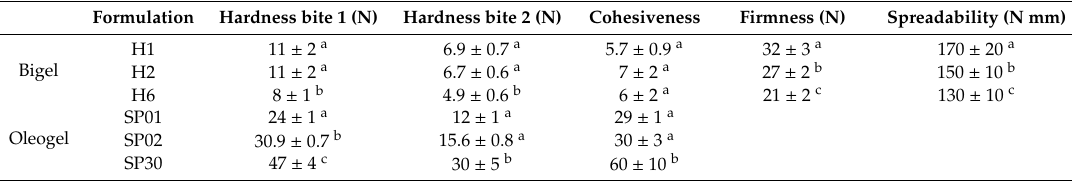
Table 4. Mechanical analysis results obtained for the di ff erent bigel formulations and oleogels consisting only of the oil phase